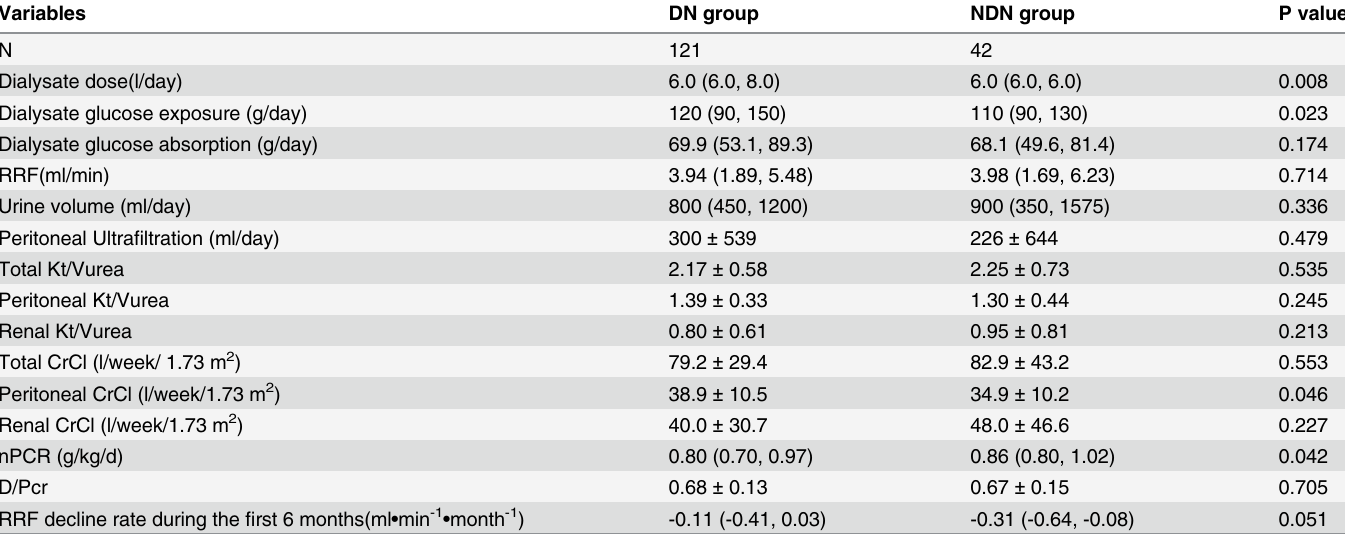
Table 2. PD prescription and adequacy